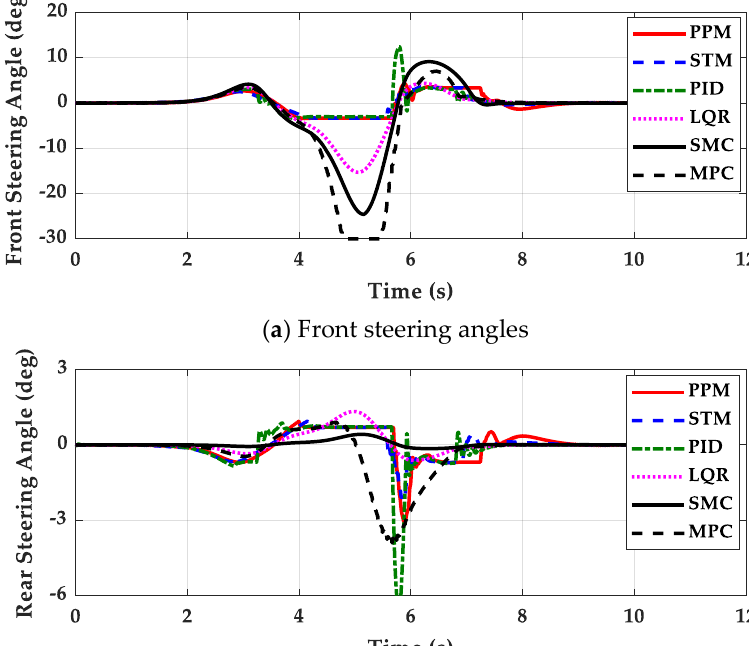
Figure 8. Simulation results of each controller for FWS vehicle on low- μ road.